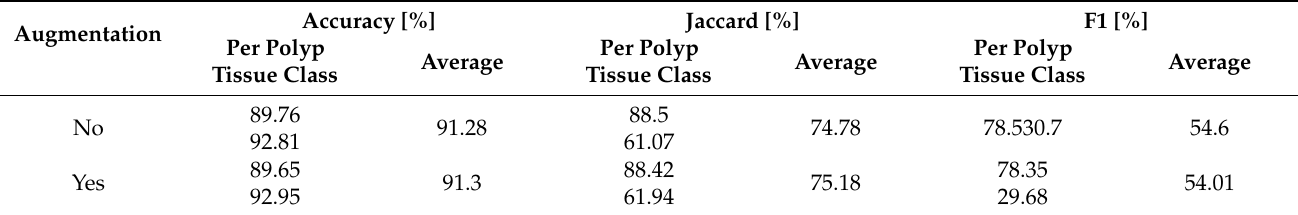
Table 11. Results for “Kvasir-seg”